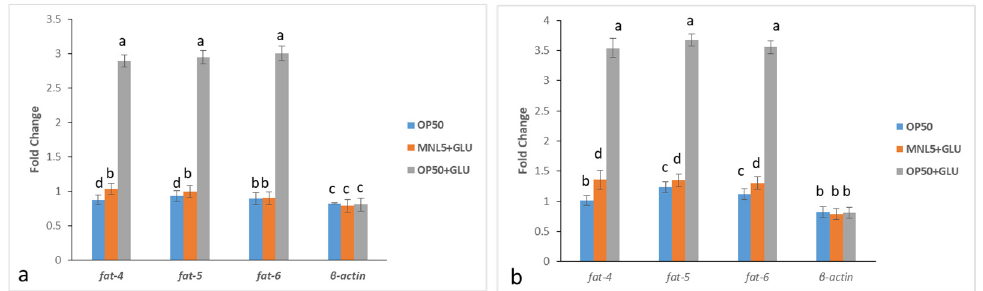
Figure 7. The qPCR fold change in expression pattern of fat genes. ( a ) DAF-2; ( b ) LIU1; The bar diagram indicates the following changes in worms exposed different diets to gene expression: OP50; MNL5+ Glucose; OP50+ Glucose. Values are expressed in mean ± standard deviation ( n = 3). Different superscripts ( a, b, c, d ) represent significantly different values ( p < 0.05).